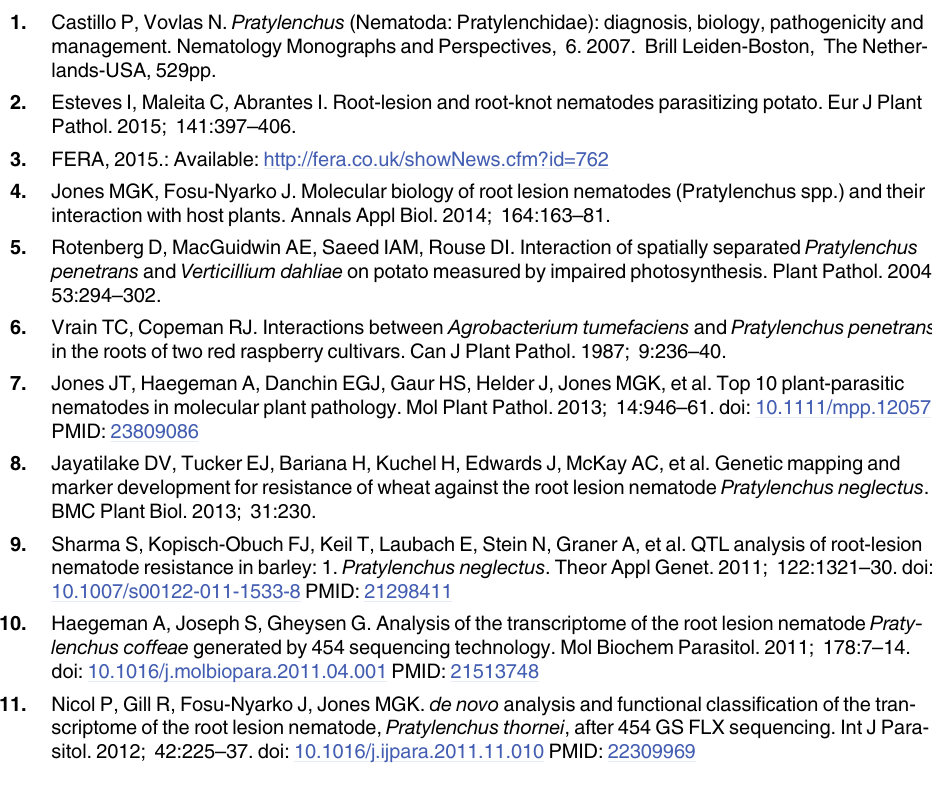
S7 Table. Summary of transcripts encoding proteases with a putative signal peptide and no TMHMM found in Pratylenchus penetrans transcriptome.